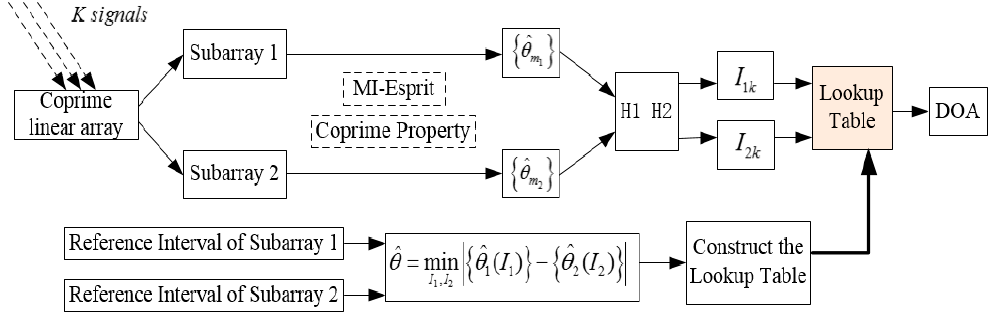
Figure 4. The calculation procedure of the proposed algorithm.